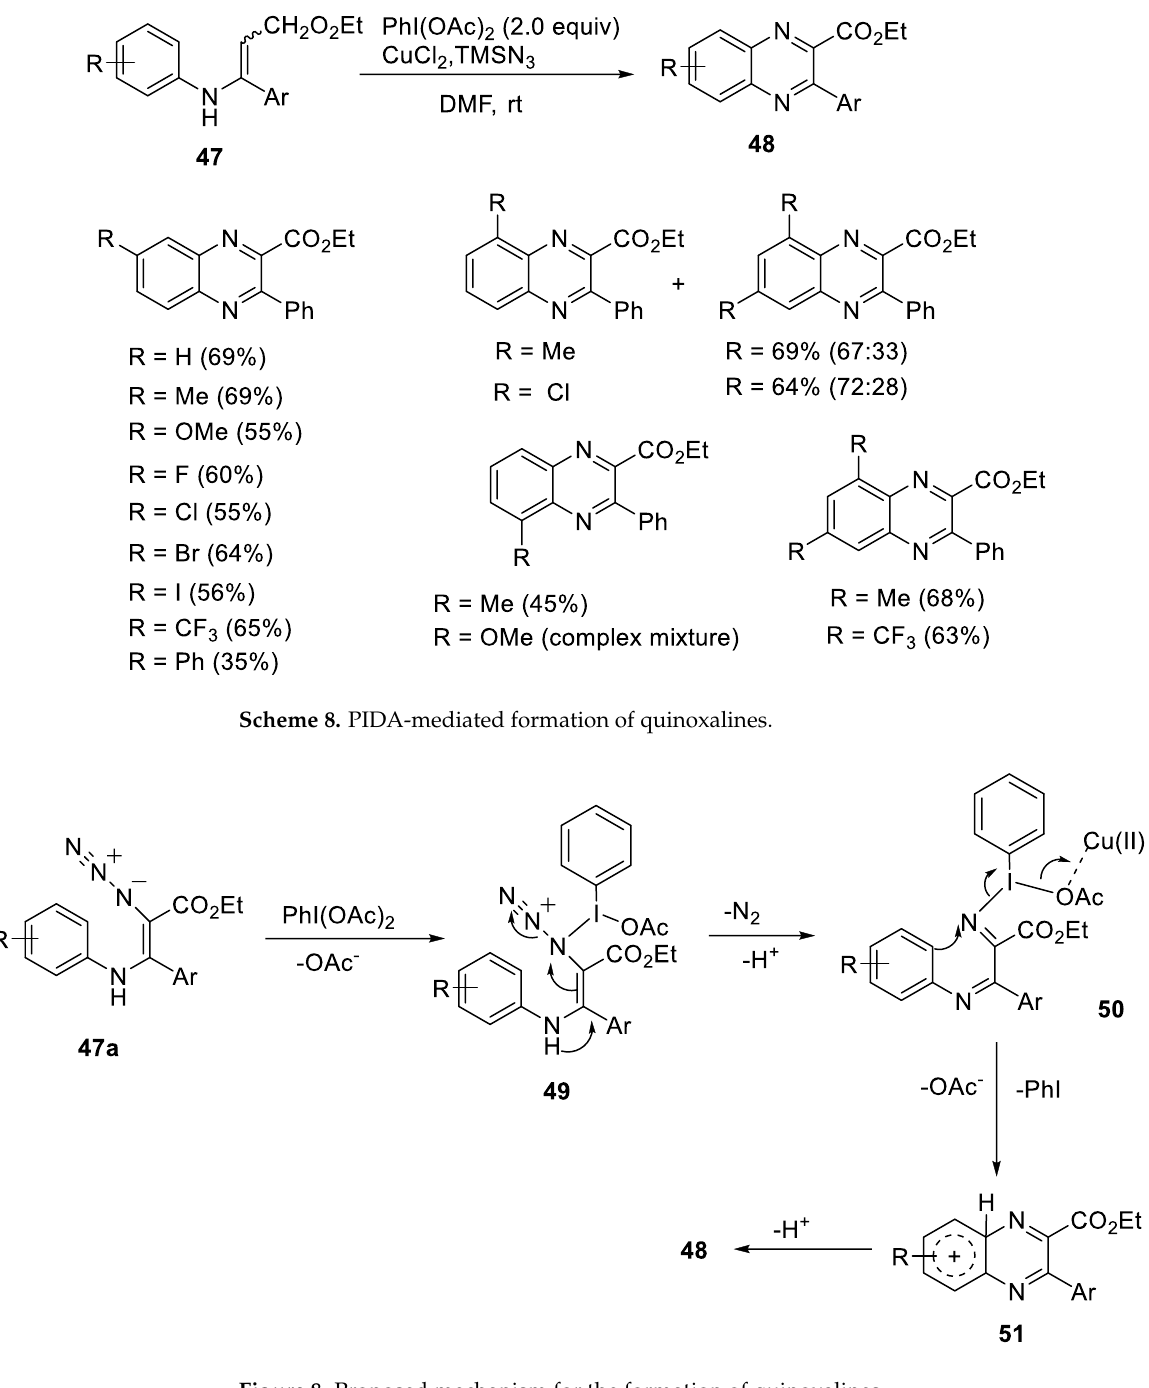
Figure 8. Proposed mechanism for the formation of quinoxalines.